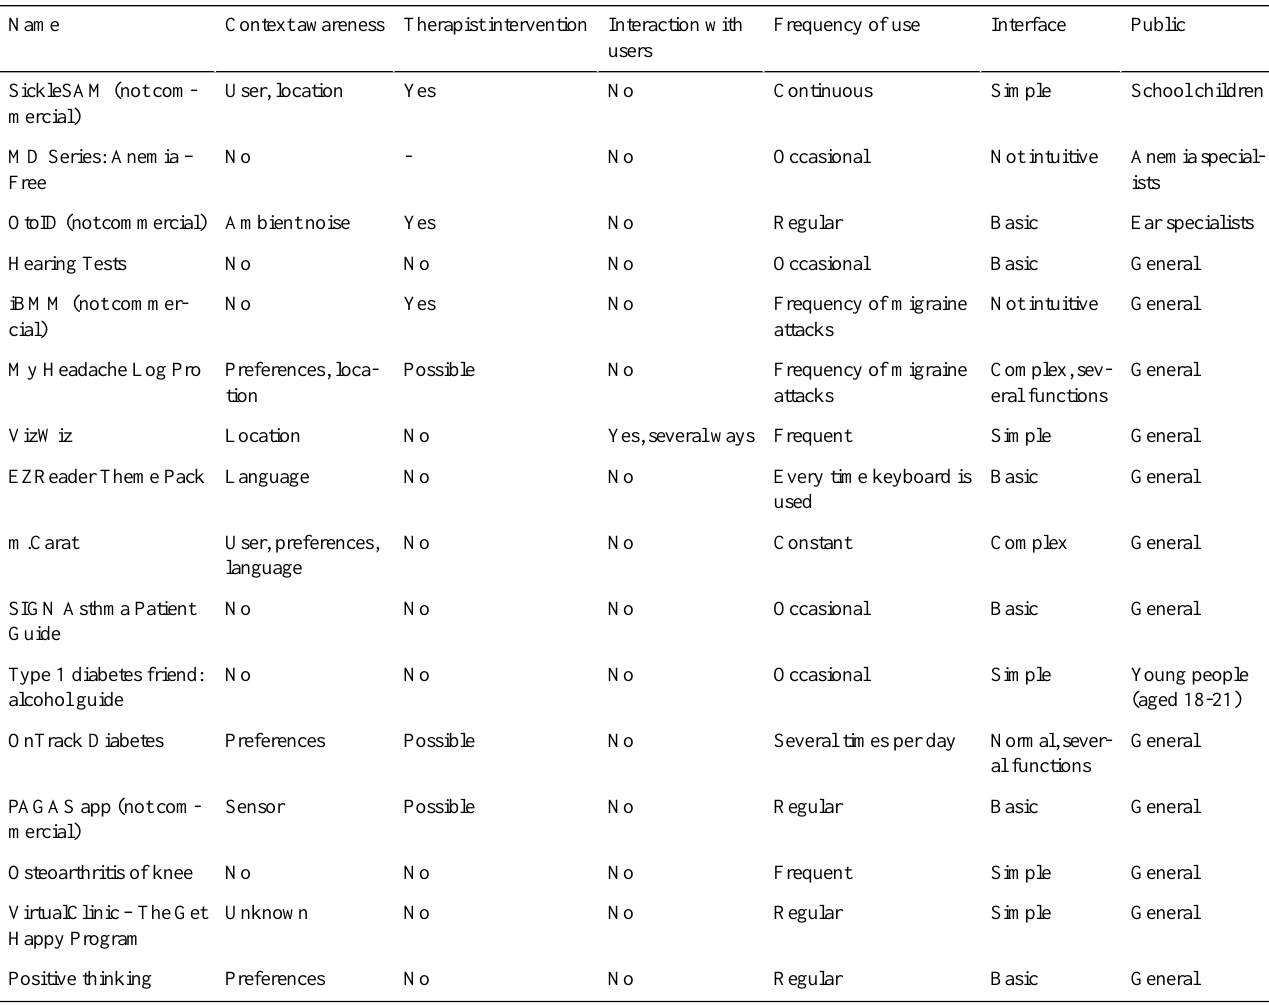
Table 5. Analysis of features (Part 2) of the selected